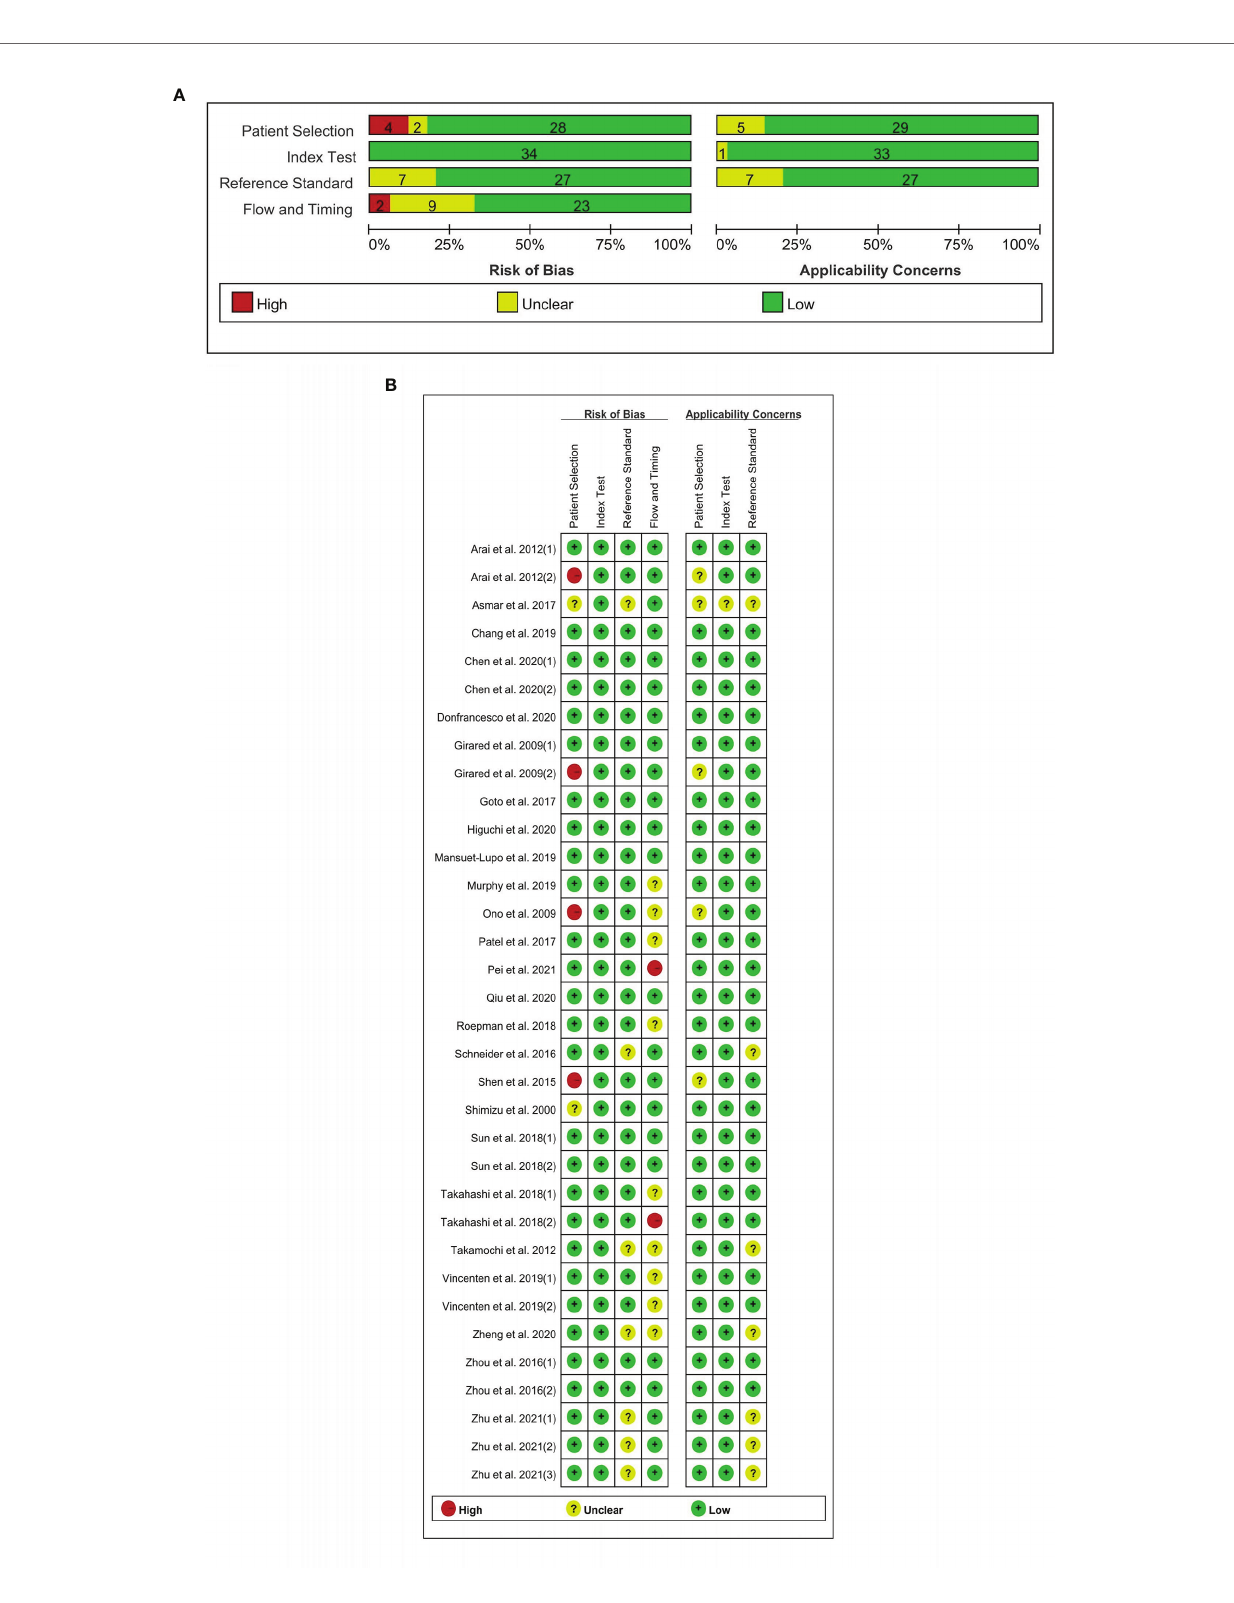
FIGURE 2 | Quality of the selected studies according to the QUADAS-2 guidelines. (A) Risk of bias graph. (B) Risk of